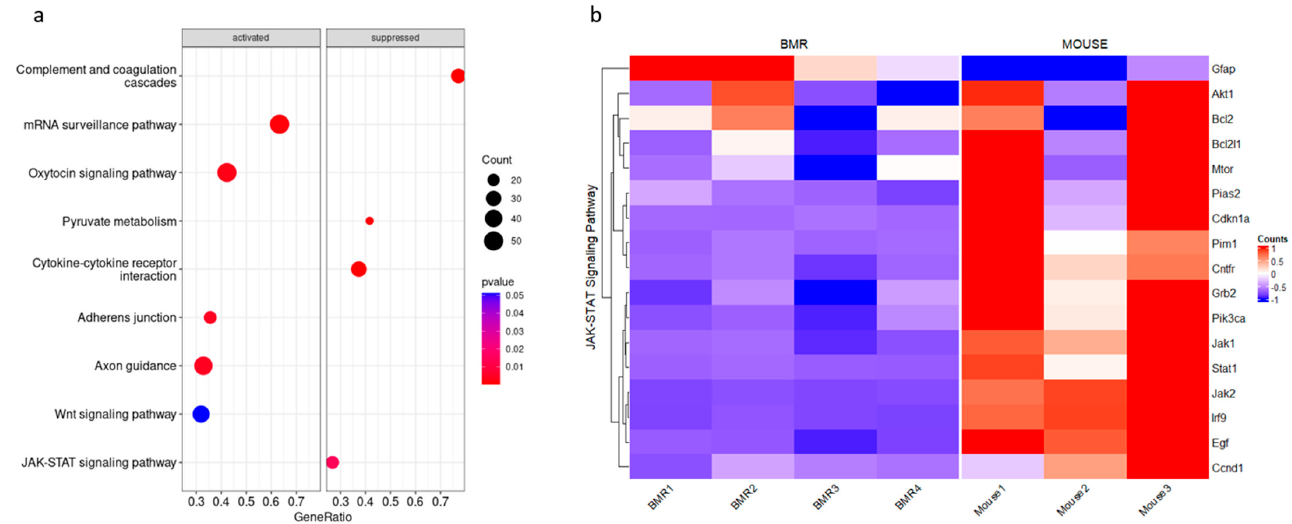
Figure 1. Comparison of differentially expressed genes between BMRs and mice (data were reana- lyzed from the transcriptome data of Altwasser et al.). ( a ) KEGG pathway enrichment analysis of consistently activated and repressed genes in BMRs ( n = 4) when compared to mice ( n = 3). The permutation of the gene set enrichment analysis is 10,000, and the cutoff p -value was selected as 0.05. RNA samples from BMRs represent the sequence data. The dot size is based on the gene count enriched in the pathway, and the color of the dot shows the pathway enrichment significance. Gene set enrichment analyses were performed with multiple test corrections (Benjamini–Hochberg). ( b ) Expression changes in JAK–STAT signaling are represented as a heatmap by using the transcrip- tome data of BMRs and mice. The columns represent individuals, and rows represent genes. Before creating the heatmap, raw gene expression abundances were scaled at the gene level, which is rep- resented as the Z-score.